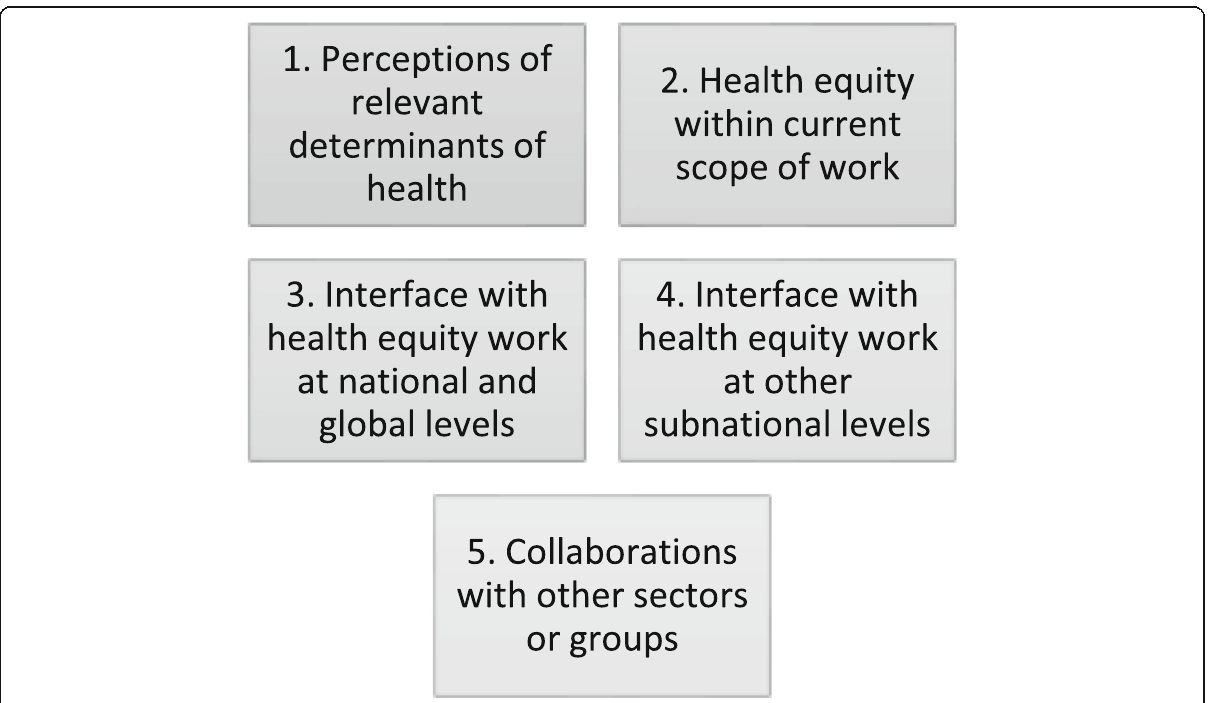
Fig. 2 Five domains of investigation in semi-structured key informant interviews with subnational health managers in